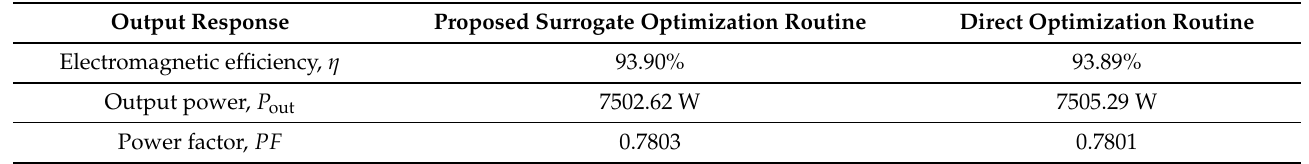
Table 16. Optimal design from the proposed surrogate optimization routine compared with the direct optimization routine.